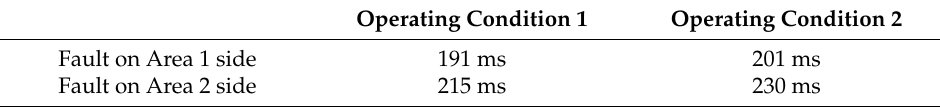
Table 1. Critical clearing times t CCT for the two simulated system operating conditions.